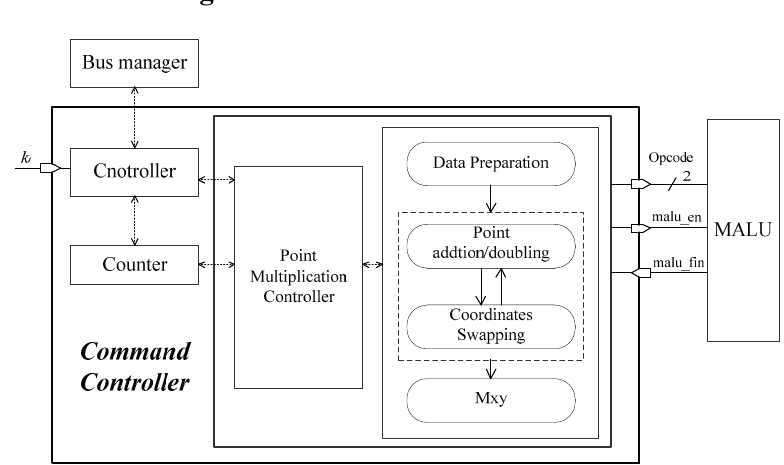
Figure 7. ECP Command Controller.